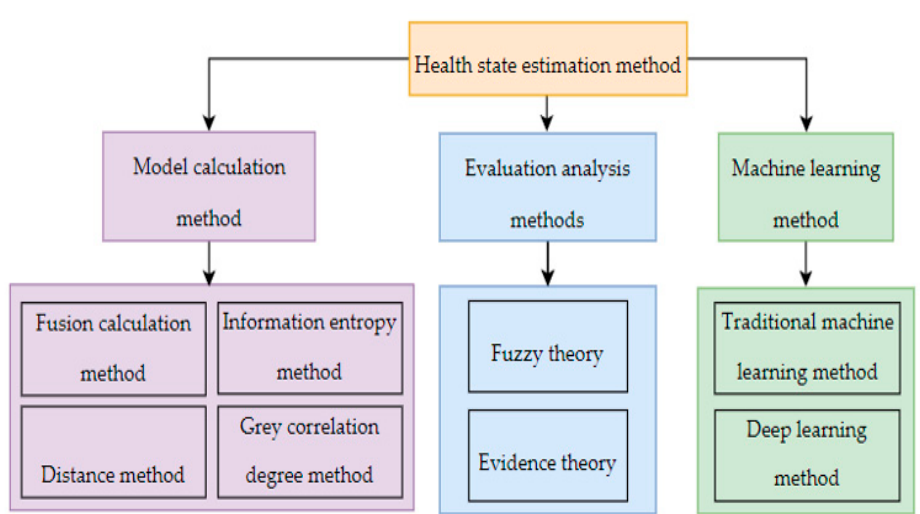
Figure 1. Classification of health state estimation methods.